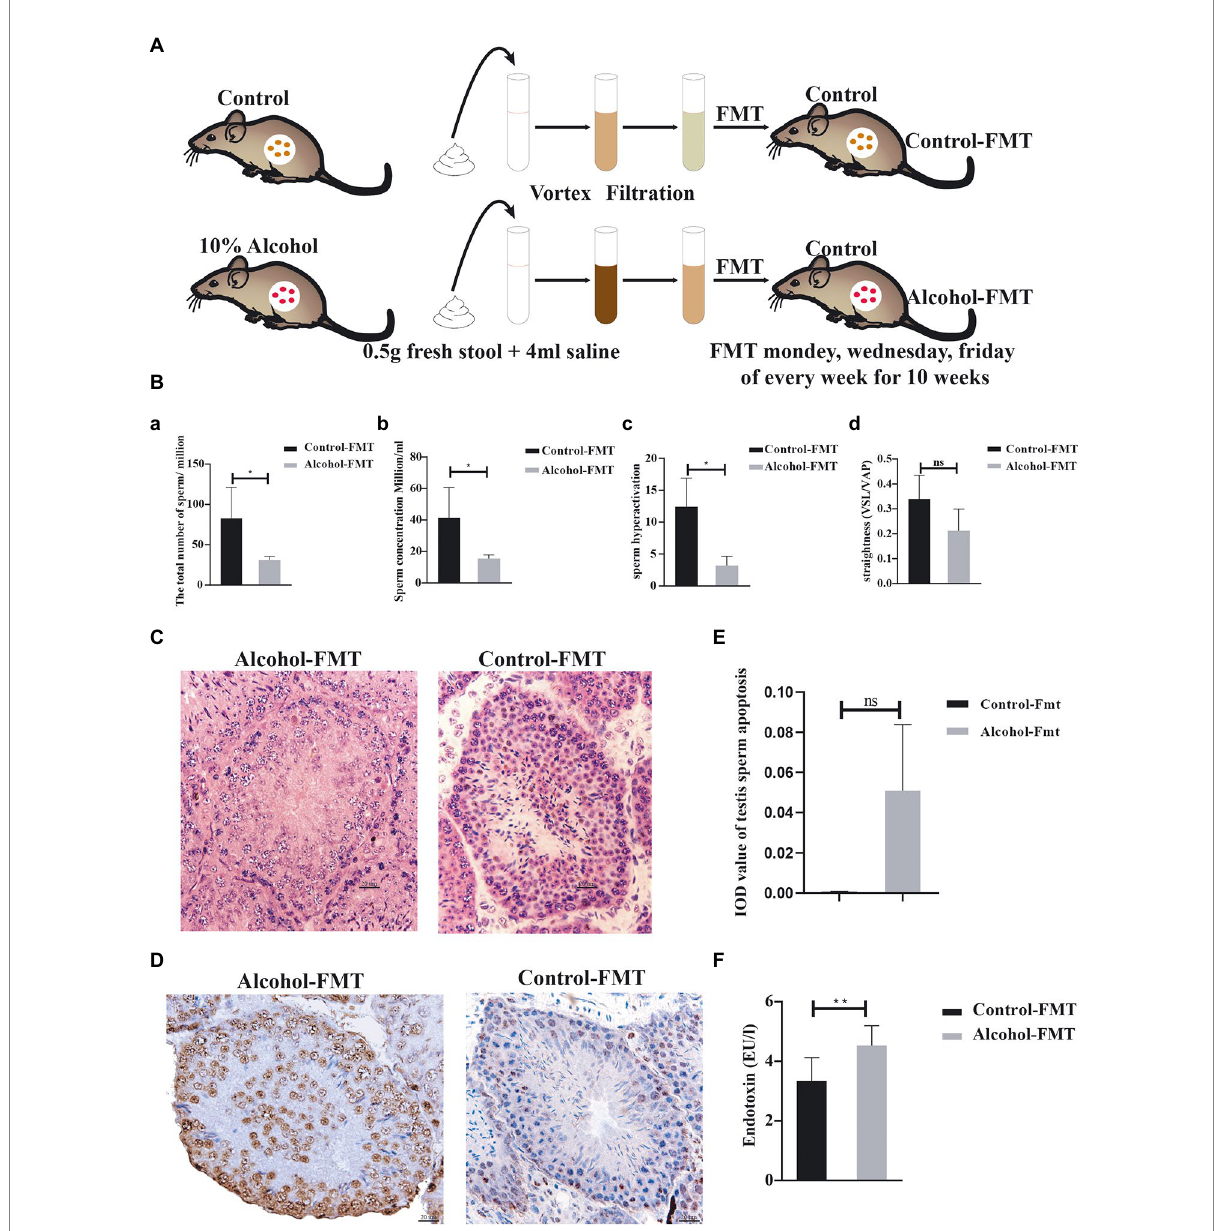
FIGURE 1 Fecal microbiota transplanted from alcohol-treated mice reduced sperm quality in recipient mice. (A) Schematic diagram of the FMT experiment. (B) — (a) The total number of sperm, (b) the concentration of sperm, (c) hyperactivation of sperm, and (d) the straightness of sperm. (C) Representative images of H&E staining showing impairment of the seminiferous tubules in the testis. Scale bar = 50 μ m. (D) TUNEL assay of seminiferous tubules in the control-FMT group and alcohol-FMT group. Cells stained dark brown are apoptotic cells, while normal cells are stained blue (200X). (E) The mean integrated optical density (IOD) of TUNEL staining in the two groups. (F) Analysis of endotoxin levels in blood from the control-FMT group and alcohol-FMT group. * p < 0.05 and ** p <